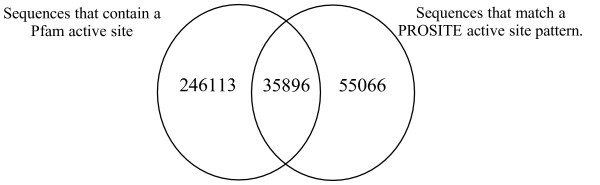
A Venn diagram comparing the number of UniProtKB sequences that contain a Pfam active site to the number of sequences that match an active site PROSITE pattern.